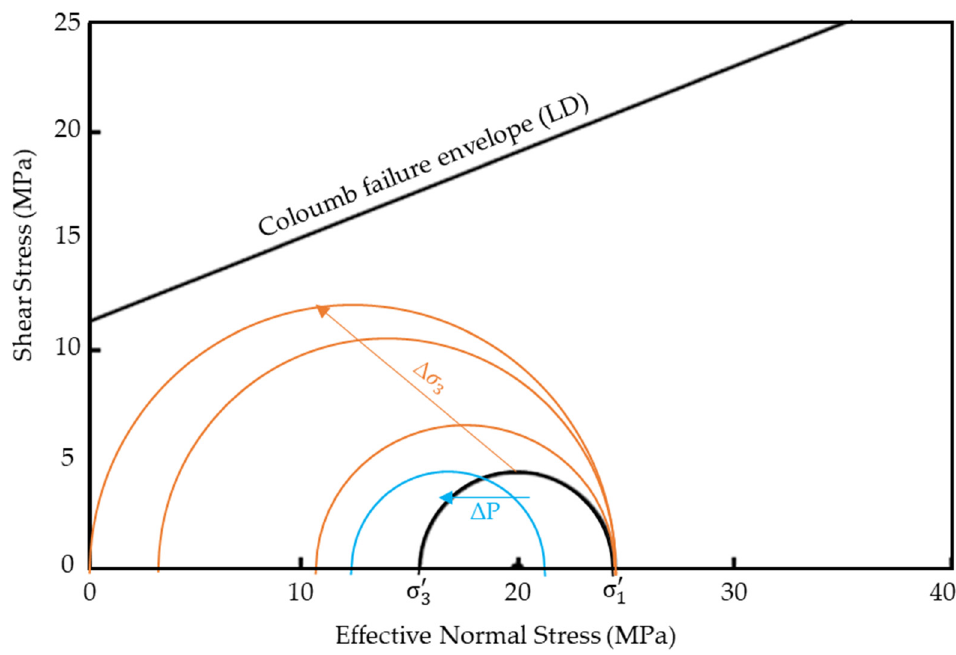
Figure 10. Mohr–Coulomb plot of lower Drake (LD) unit in initial state stress condition (black). Examples of Mohr circles’ shift due to pore pressure increase (blue) and σ 3 decrease (brown) are illustrated for an explanation of failure results.